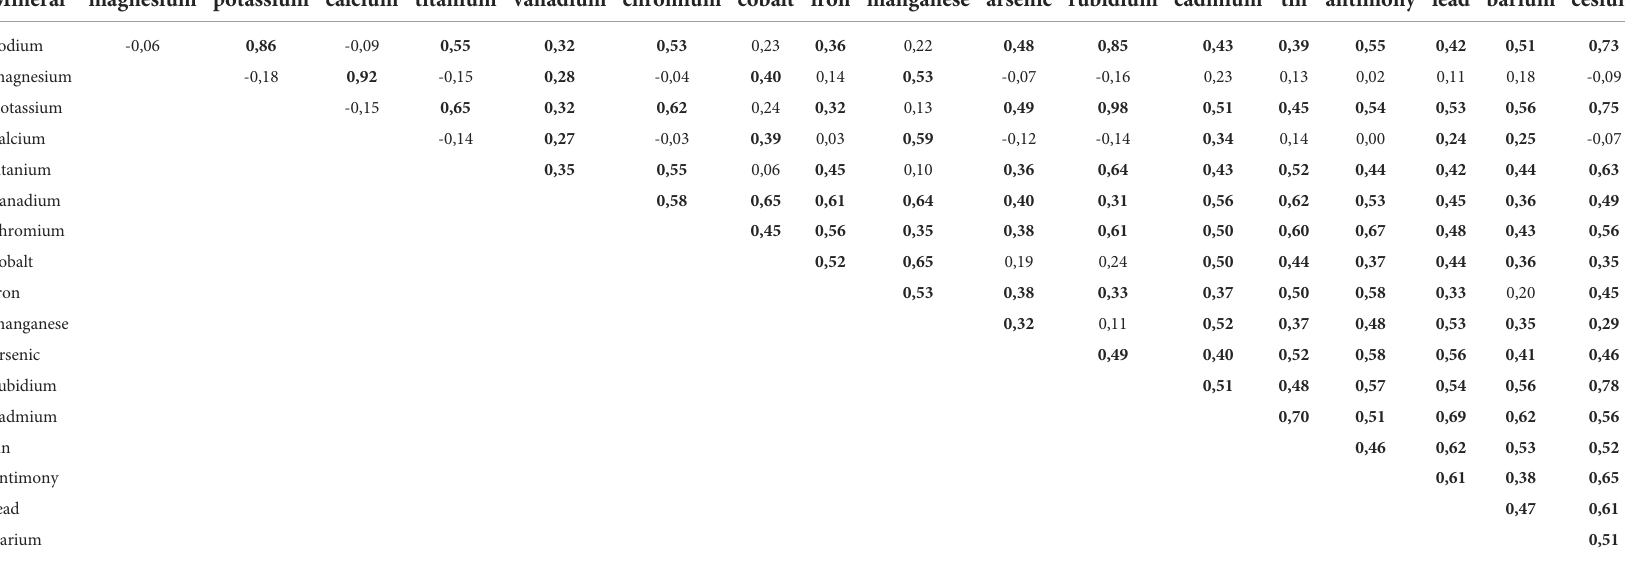
TABLE 2 Spearman correlations of mineral content in wrestlers (N =